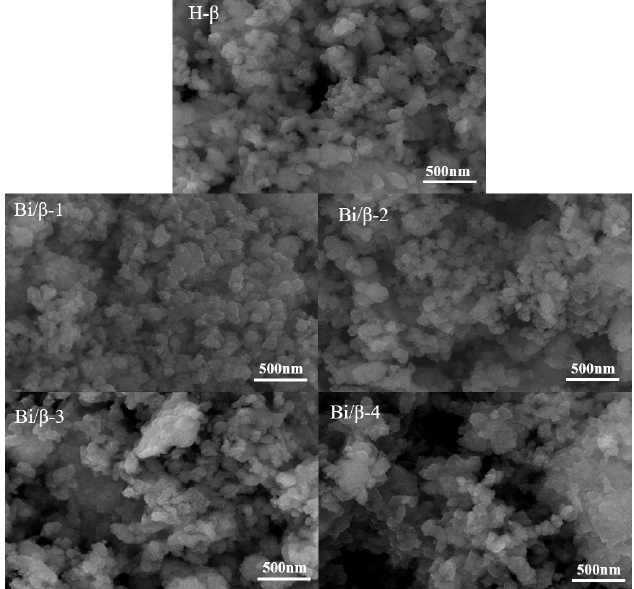
Figure 2. SEM images for H- β and Bi/ β catalysts with different Bi loading. Table 1. Textural properties and contents of Bi of various β